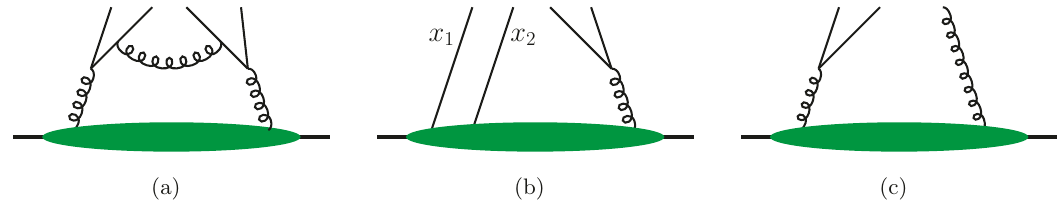
Figure 5 . (a) A higher order contribution to the splitting part of a DPD. (b) Graph for a DPD with perturbative splitting only to the right of the final-state cut. The blob denotes a distribution D α . (c) Graph for perturbative splitting in the distribution D α 1 α 2 | α 0